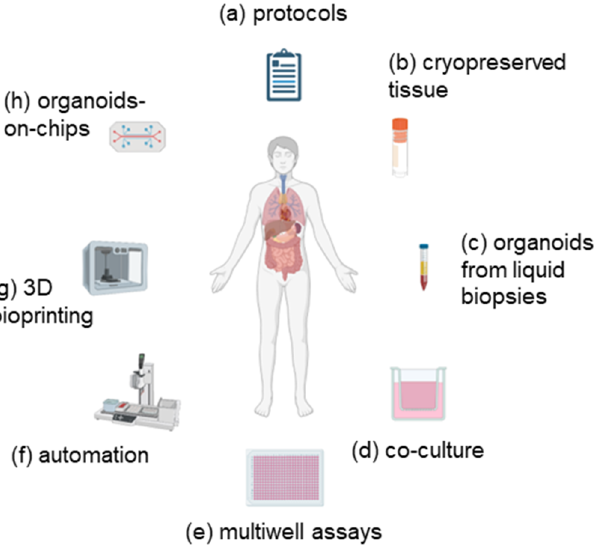
Figure 1. Use of emerging technologies to improve organoid assays. In order to overcome the limitations of organoid cultures and improve their efficiency, new developments are required. These are described in more detail in the text and may include ( a ) the use of enhanced or standardized protocols; ( b ) use of cryopreserved tissue; ( c ) establishment of organoids from circulating tumour cells; ( d ) co-culture with components of the tumour microenvironment; ( e ) assays in multi-well formats; ( f ) automated processes for establishment and testing; ( g ) 3D bioprinting; ( h ) use of organoids-on-chips. Image created with Biorender.com.